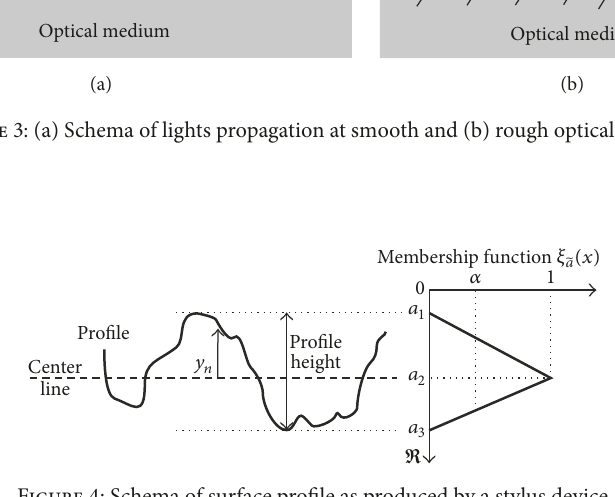
Figure 4: Schema of surface profile as produced by a stylus